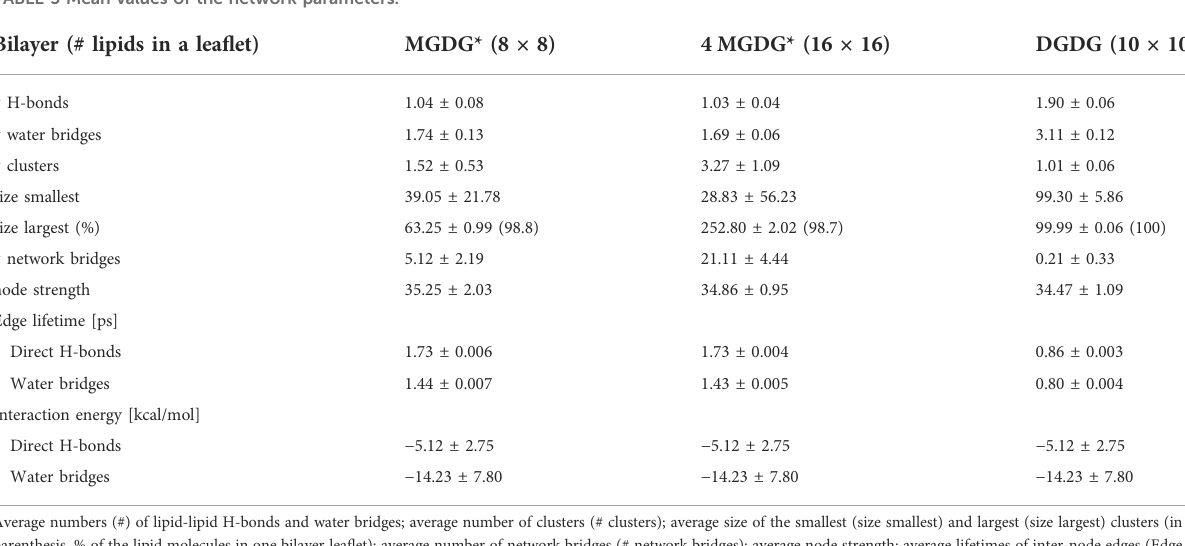
TABLE 5 Mean values of the network parameters.